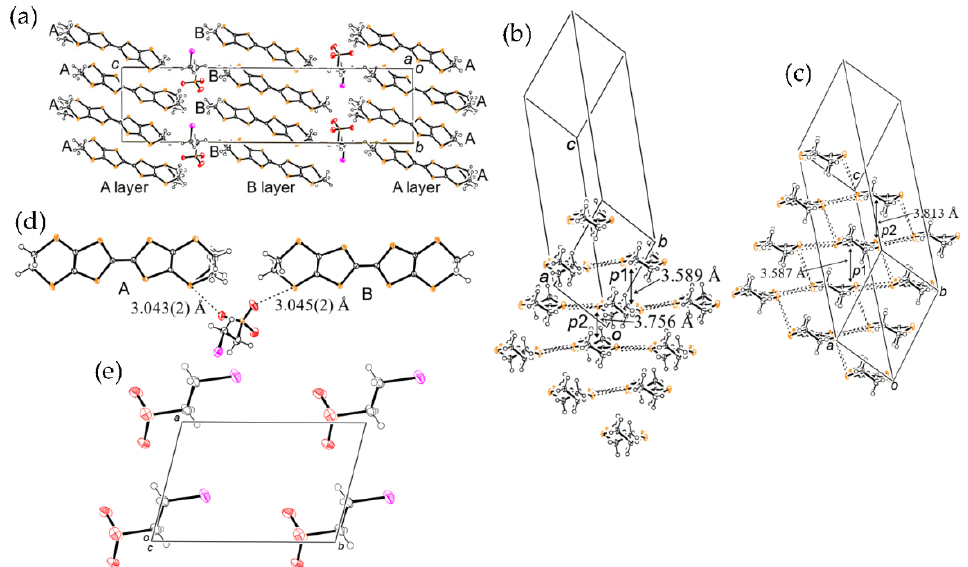
Figure 1. ( a ) Crystal structure, donor arrangements of ( b ) A and ( c ) B layers with two crystallographically-independent plane–plane distances, where the dashed lines indicate S···S contacts shorter than the van der Waals distance of 3.70 Å, ( d ) short contacts between donors and anions, and ( e ) structure of the anion layer of 1 .